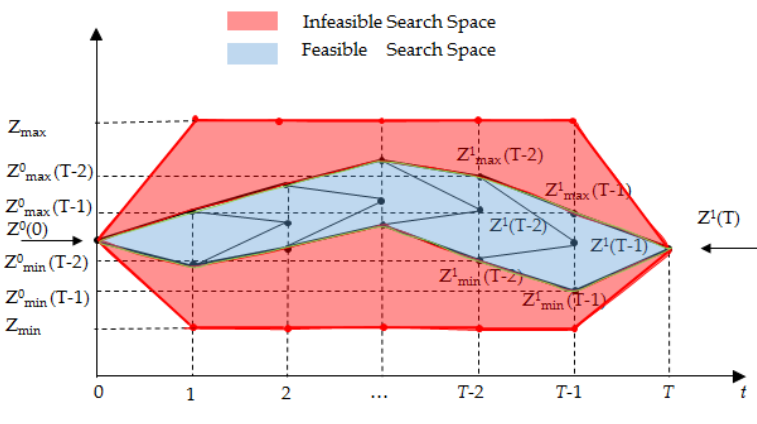
Figure 4. Optimization of the feasible search space.